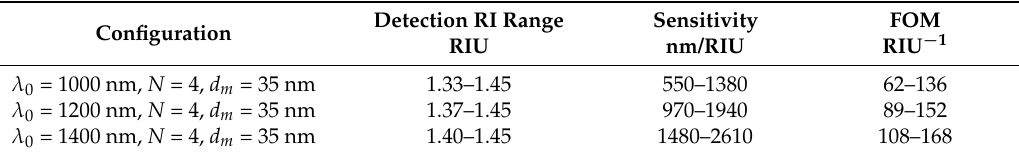
Table 1. Comparison between the proposed sensors with different center